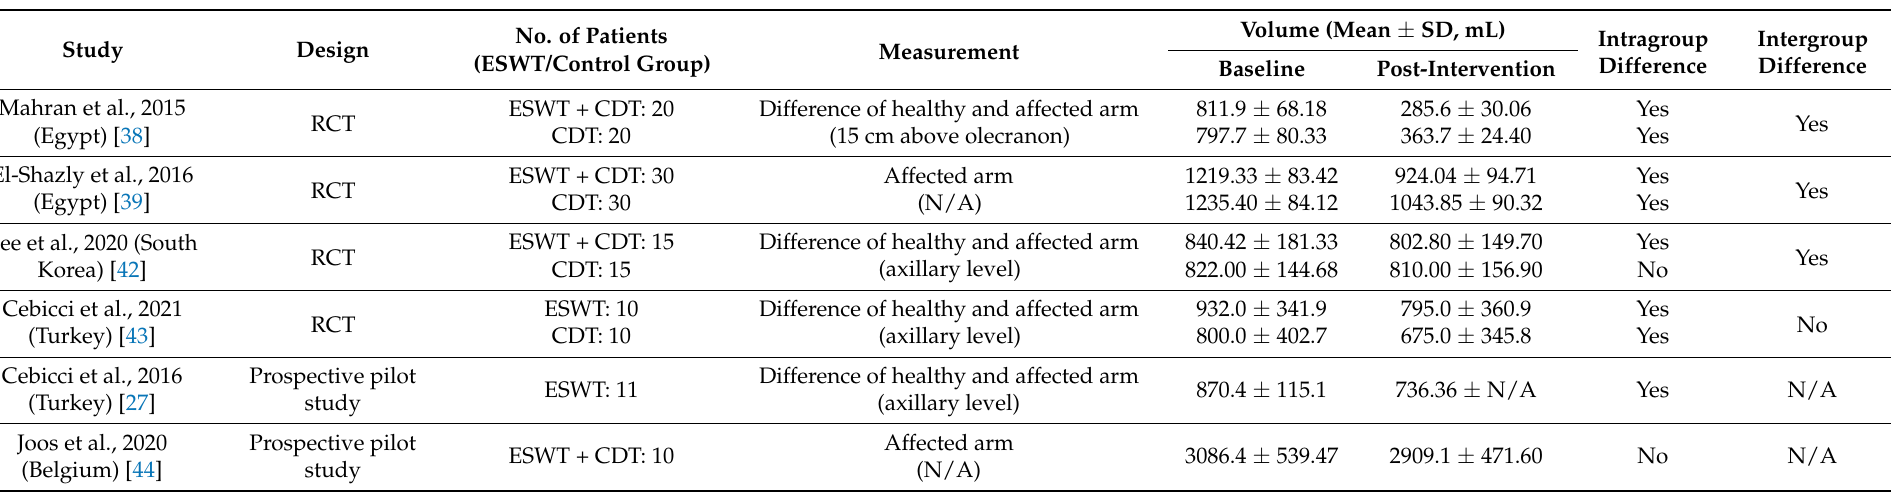
Table 5. Outcome measurements of the volume of included studies for ESWT in